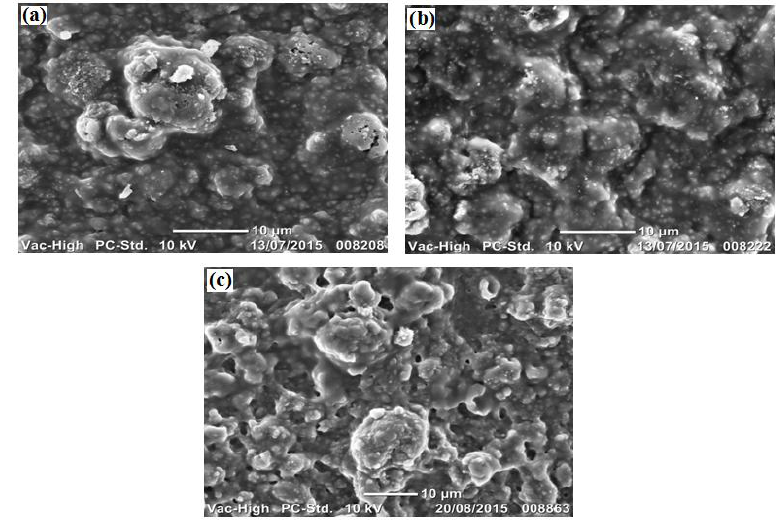
Figure 7. SEM images showing membrane surface of ( a ) original unused PU-PTFE; ( b ) PU-PTFE after MD with MMF filtered BStW2, and ( c ) PU-PTFE after MD with BStW1.